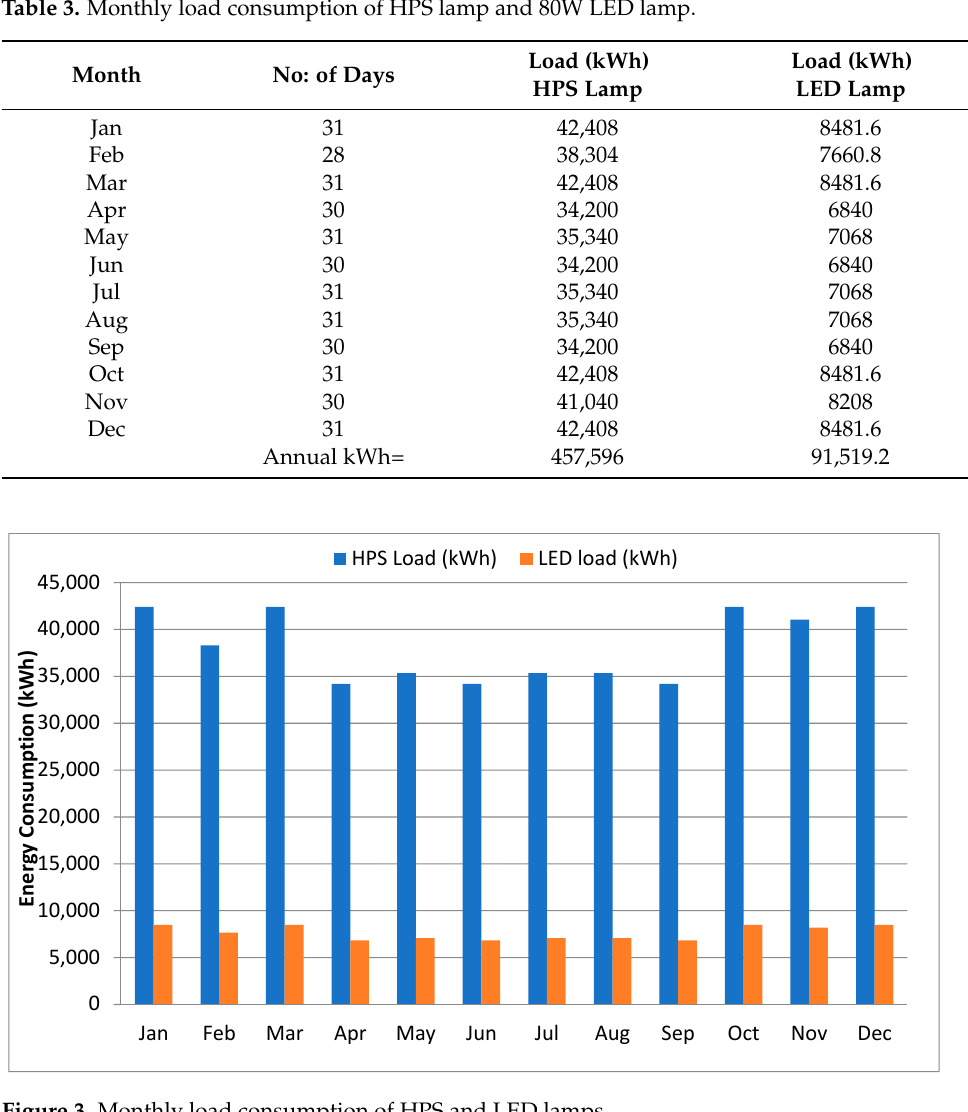
Table 4. Economic analysis of replacing HPS lamps with LED lamps.